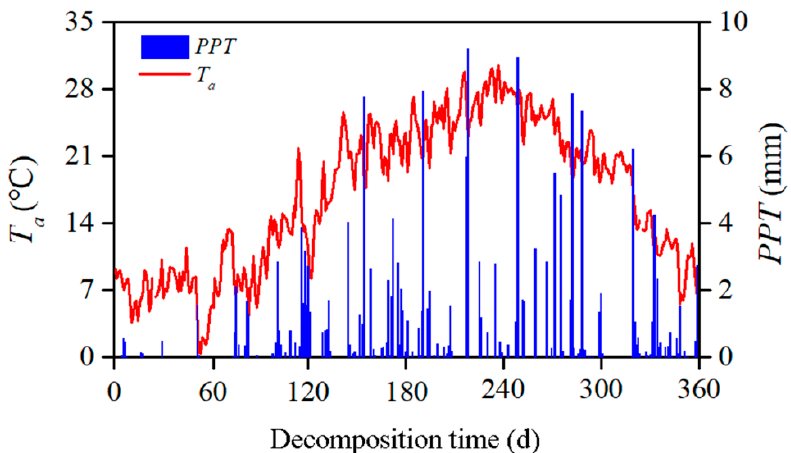
Figure 2. Dynamics of the daily average atmospheric temperature ( T a , red line) and precipitation ( PPT , blue column) from 6 December 2014, to 30 November 2015 (totaling 360 days of exposure, the data are from the local weather station located in Zigui County). The x-axis shows the decomposition time in days, with the time of litterbag placement as day 0.